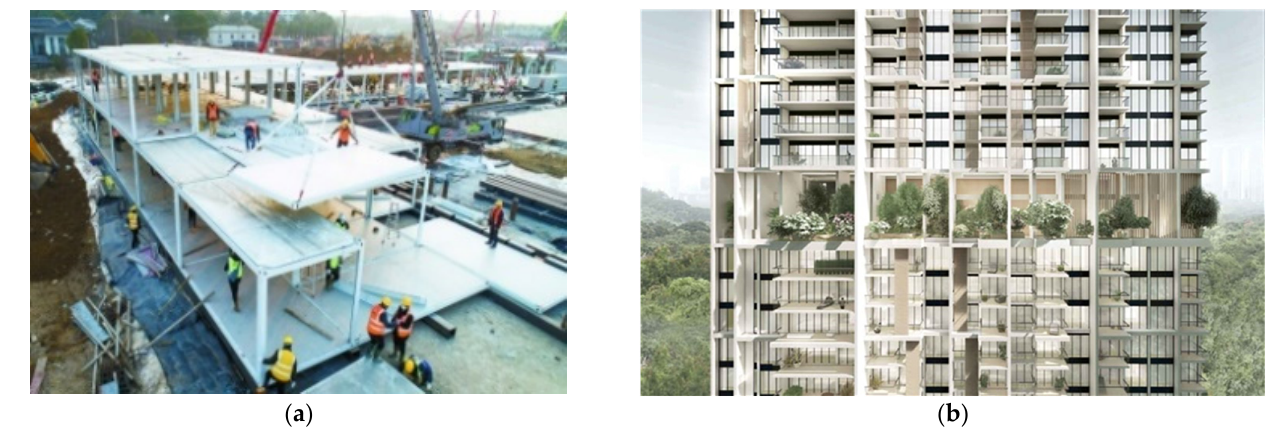
Figure 1. Mid-to-high modular construction: ( a ) Huoshenshan Hospital [7]; ( b ) 19 m tall towers [8].